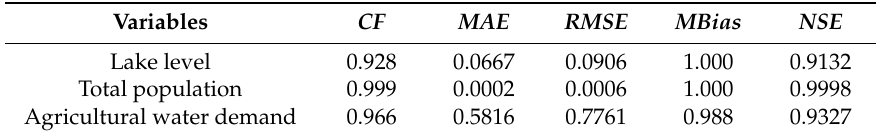
Table 1. Analysis of the model validation for simulated and observed values of